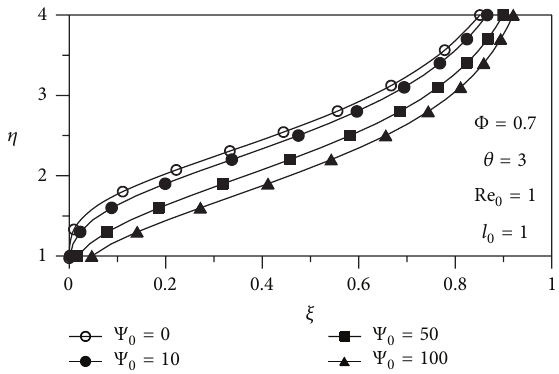
Figure 9: Effect of Ψ 0 on optimum profile of metal content.